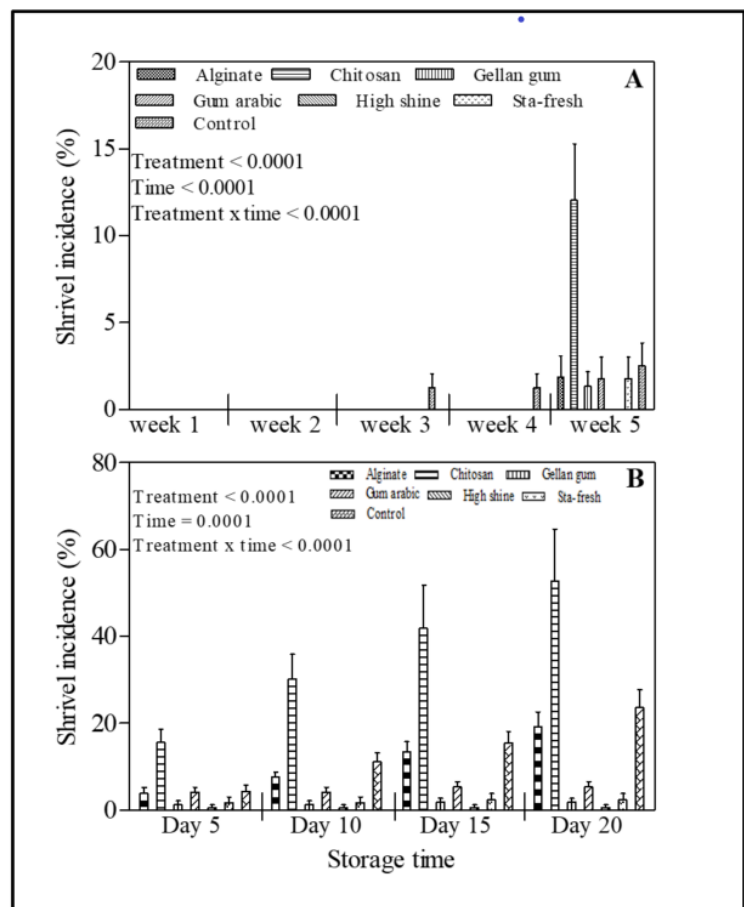
Figure 2. Cumulative shrivel occurrence (%) in ‘African Delight™’ plums during ( A ) a simulated shipping period (cold storage; −0.5 ± 2 °C and 90 ± 5% RH for 5 weeks) and ( B ) a subsequent shelf life period (20 ± 2 ◦ C and 75 ± 5% RH for 20 d). Each bar represents mean ± standard error. In other to determine the interaction e ff ects, factorial ANOVA was performed for main factors; treatment and storage time separately for cold storage and shelf life